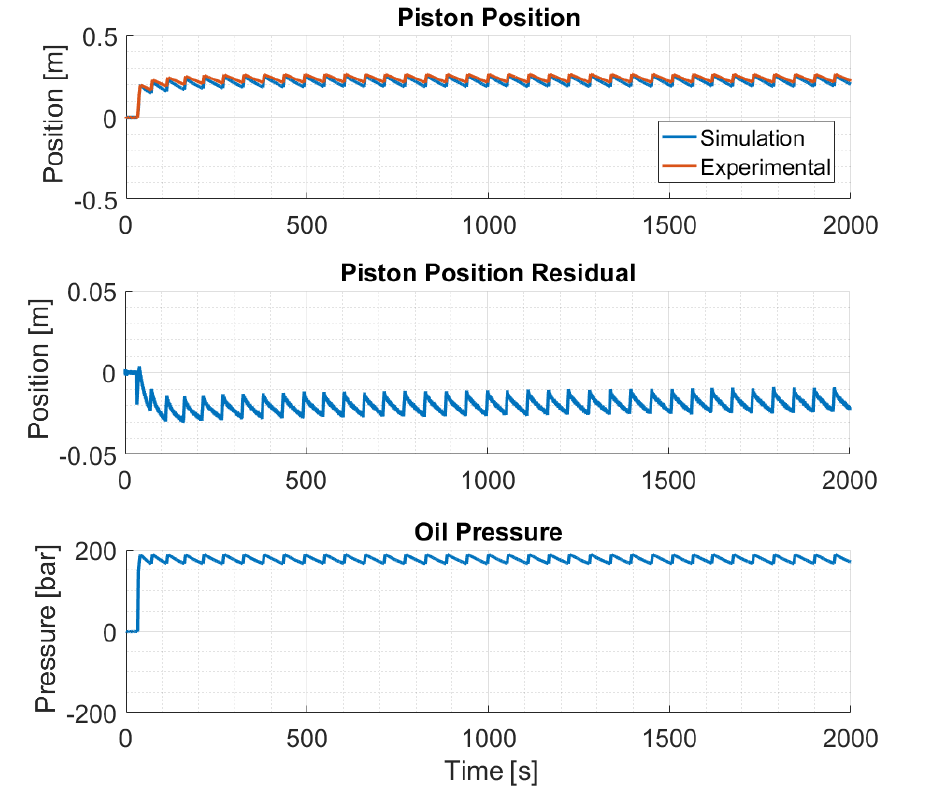
Figure 7. Simulated and experimental piston position for a test sequence emulating the operation of a supply accumulator. The position residual is defined as the difference between the simulated and experimental